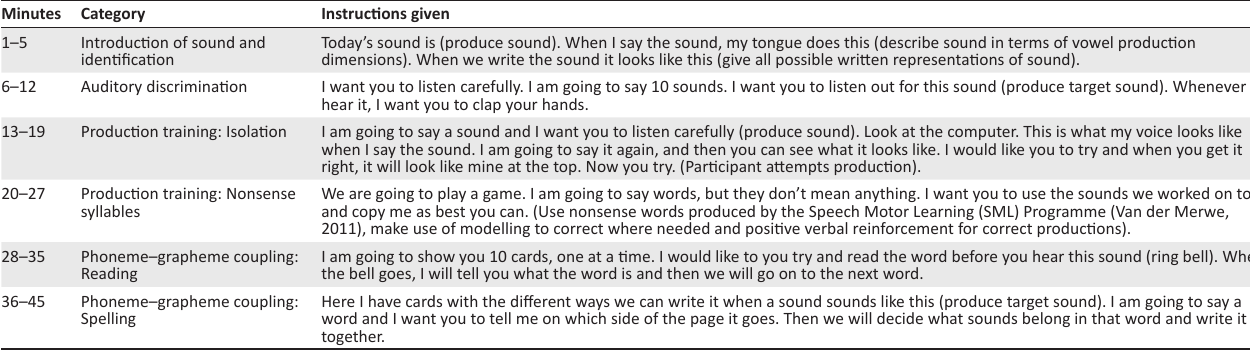
TABLE 1-A1: Intervention